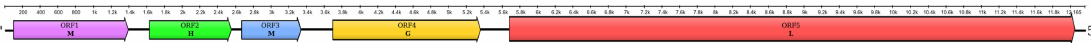
reading frame (ORF). N: nucleoprotein; H: hypothetical protein; M: matrix protein; G: glycoprotein; and L: RNA-dependent RNA